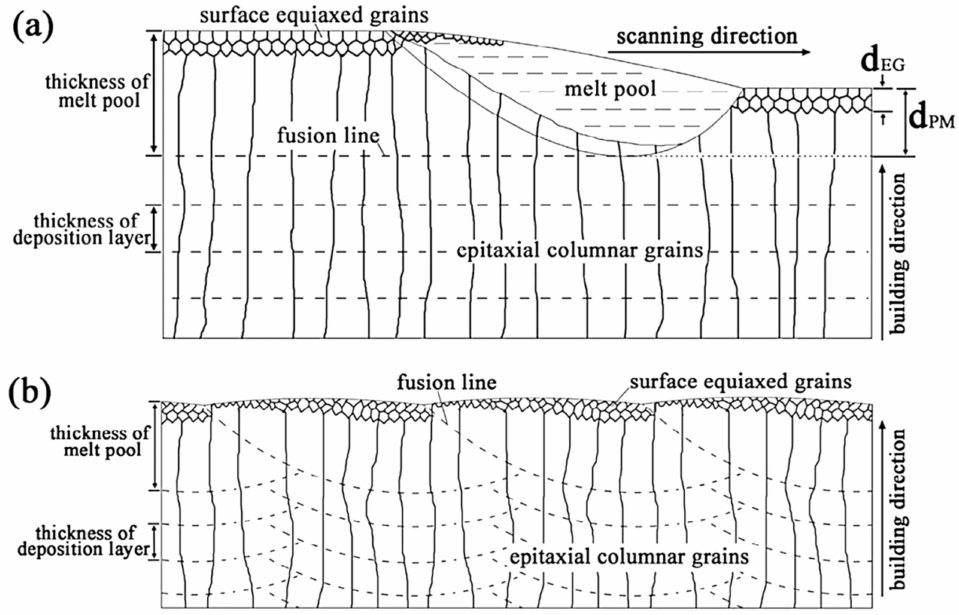
Figure 7. Schematic illustration for the formation of large columnar grains for titanium alloy components during the layer-by-layer laser melting deposition in longitudinal ( a ) and transverse ( b ) cross sections (reproduced with permission from [87] Copyright Elsevier,